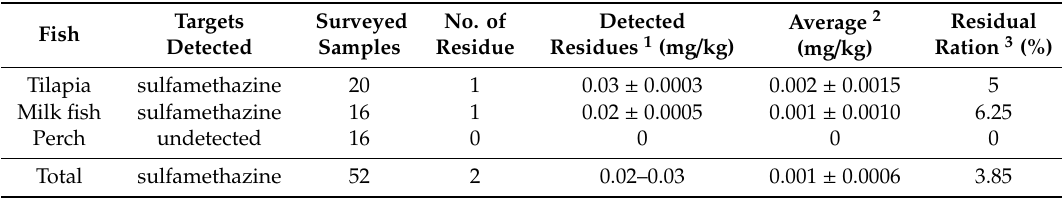
Table 1. Detected levels of residues of prohibited sulfonamides in fish samples collected over June 2018 to October